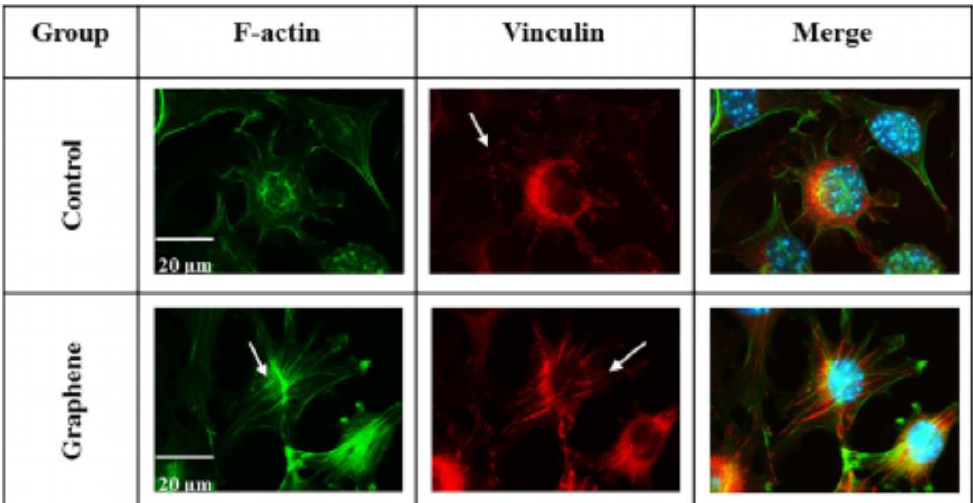
Figure 5. Immunolabeling of L929 cells grown for 24 h on the glass (control) and pristine graphene monolayer: phalloidine-FITC for actin cytoskeleton (green), anti-vinculin antibody for vinculin (red), and Hoechst 33342 stain for DNA (blue). White arrows indicate actin stress fibers (left panel) and focal adhesion protein — vinculin (middle panel). Reproduced from [95] with permission of Elsevier.